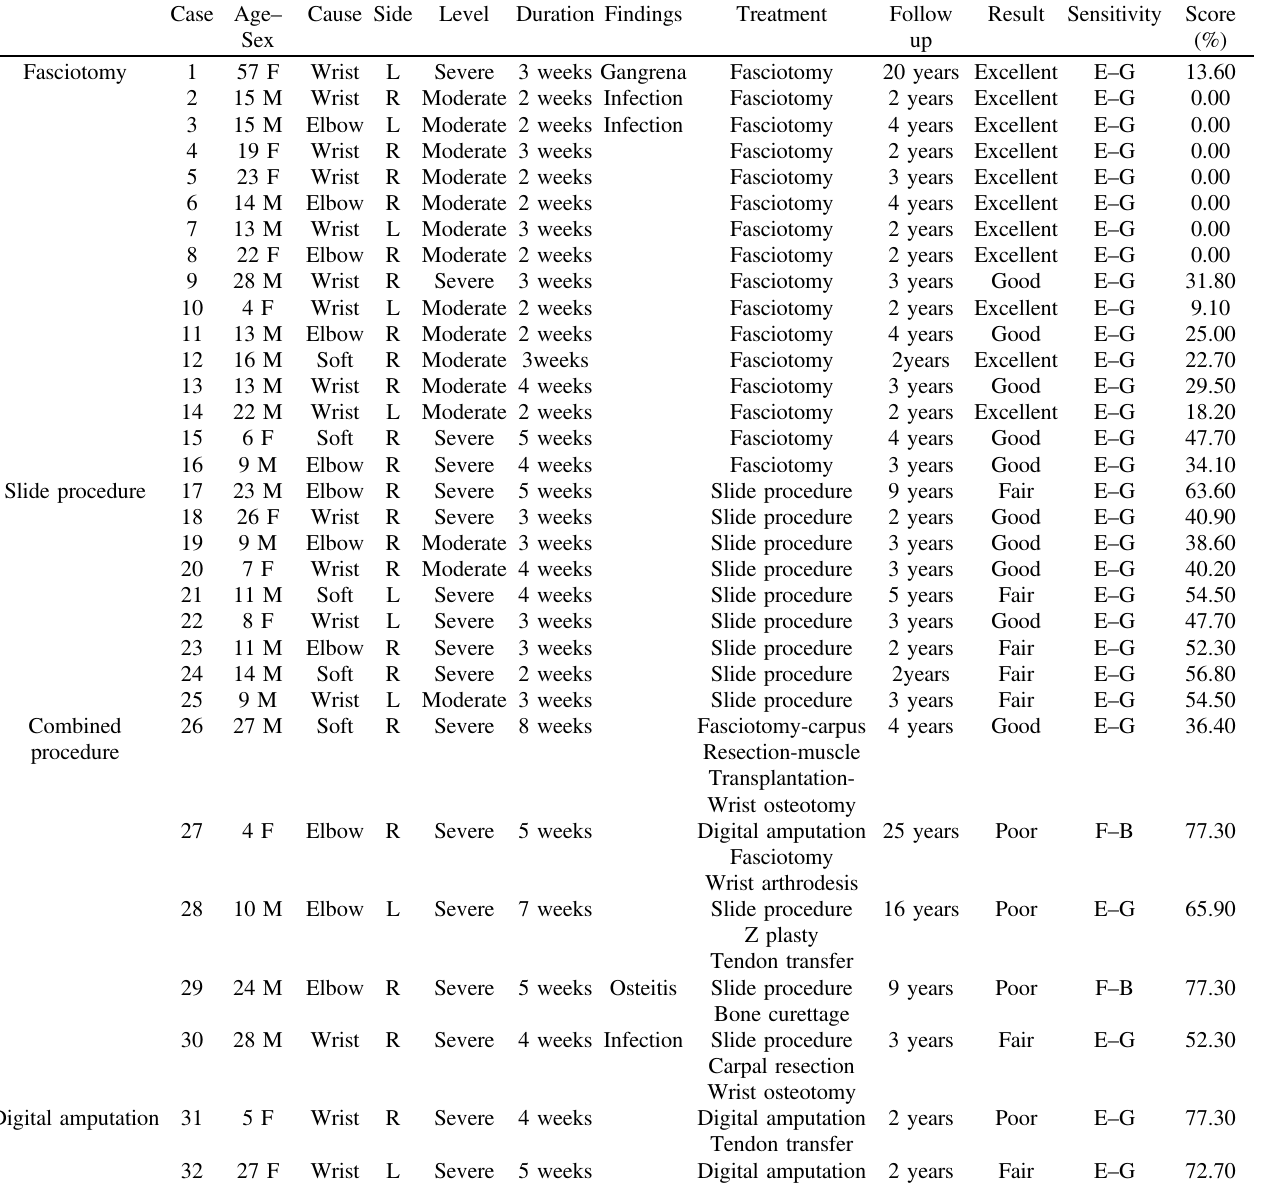
Table 1. Characteristics of patients, options, and results of